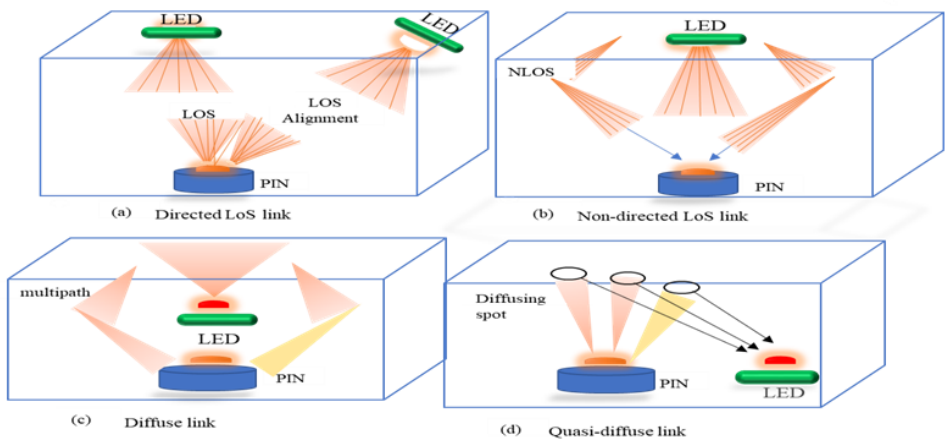
Figure 1. Typical Optical Link